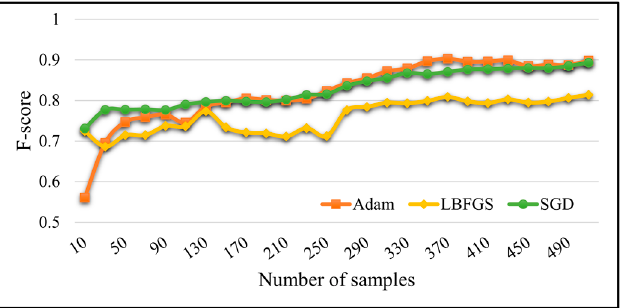
Figure 10. The obtained F ‐ score values using three ANN models with a limited number of training samples for each class.